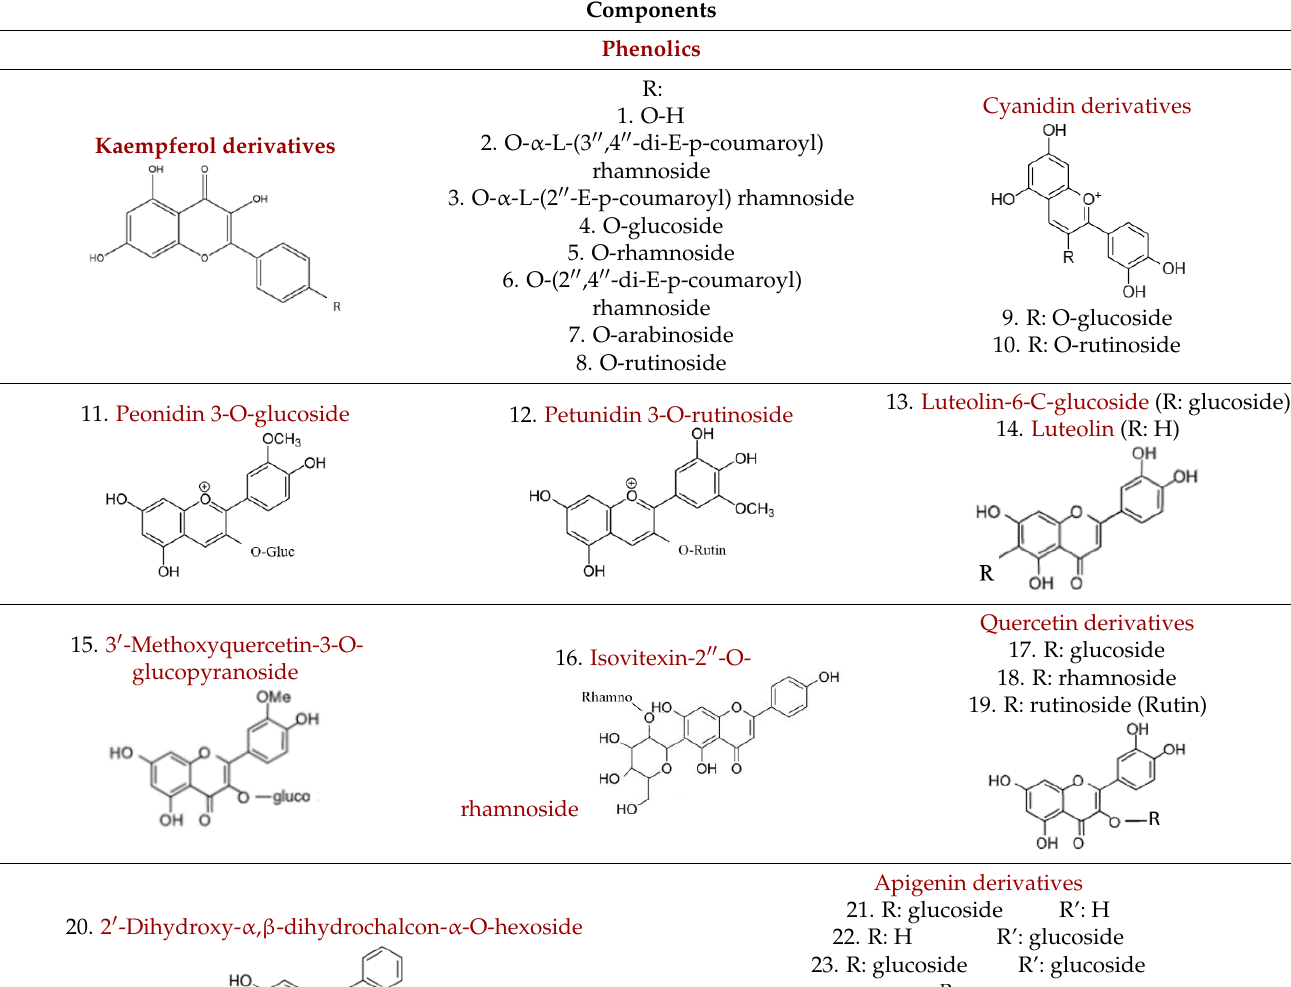
Table 2. Components of leaves, fruits, essential and fixed oil of L. nobilis.